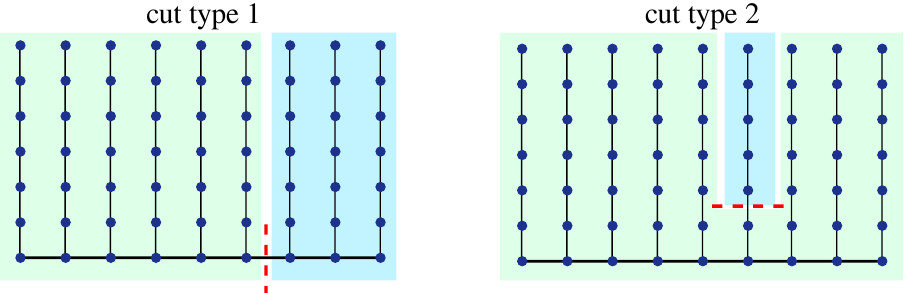
Figure 3: (Color online) Two types of bipartition used in this work to compute the entanglement entropy, background colors mark two subsystems created upon the